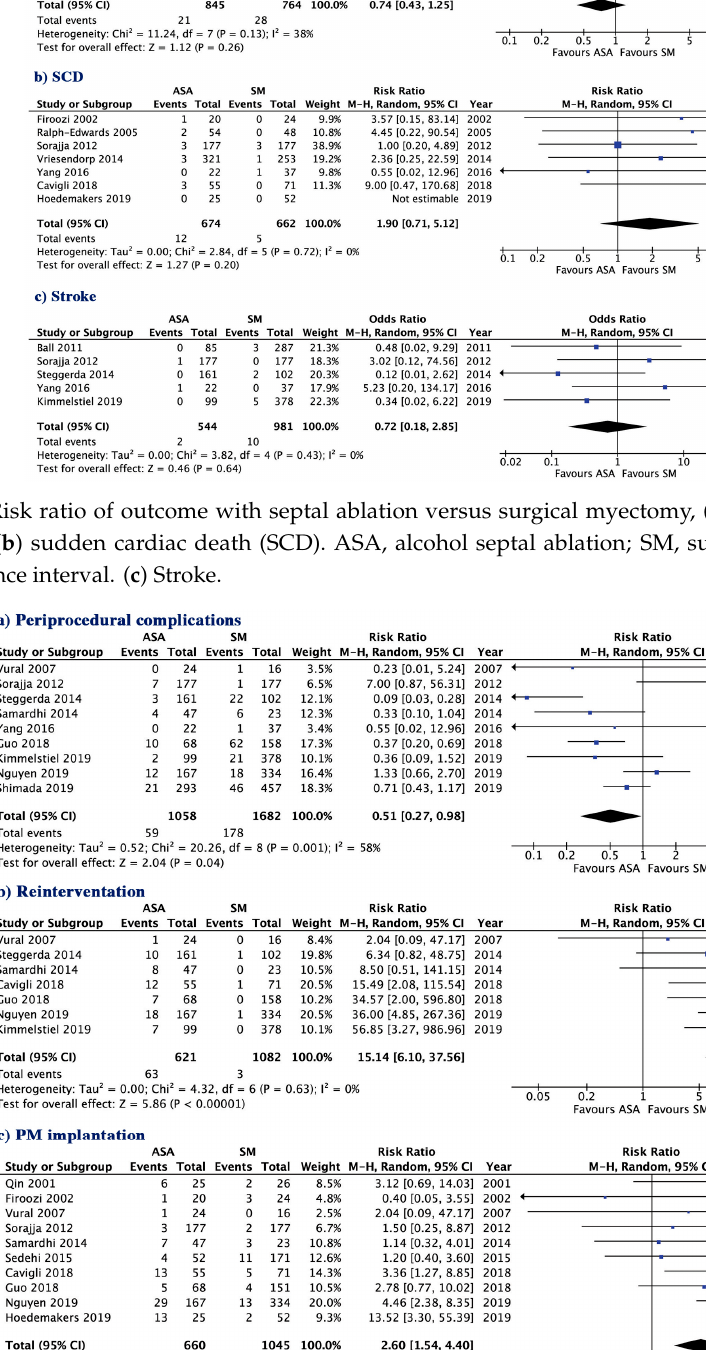
Figure 3. Risk ratio of outcome with septal ablation versus surgical myectomy, ( a ) Peri-procedural complications; ( b ) Re-intervention; ( c ) PM implantation. ASA, alcohol septal ablation; SM, surgical myectomy; CI, confidence interval; PM, pacemaker